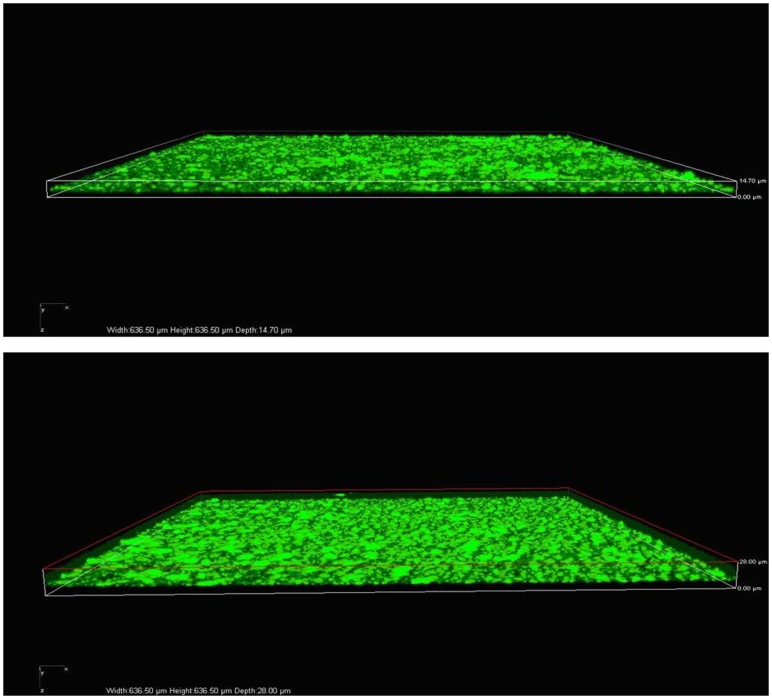
CLSM of the strain Sm1219 of S. maltophilia biofilm mode in 8 h (up) and 24 h (down).